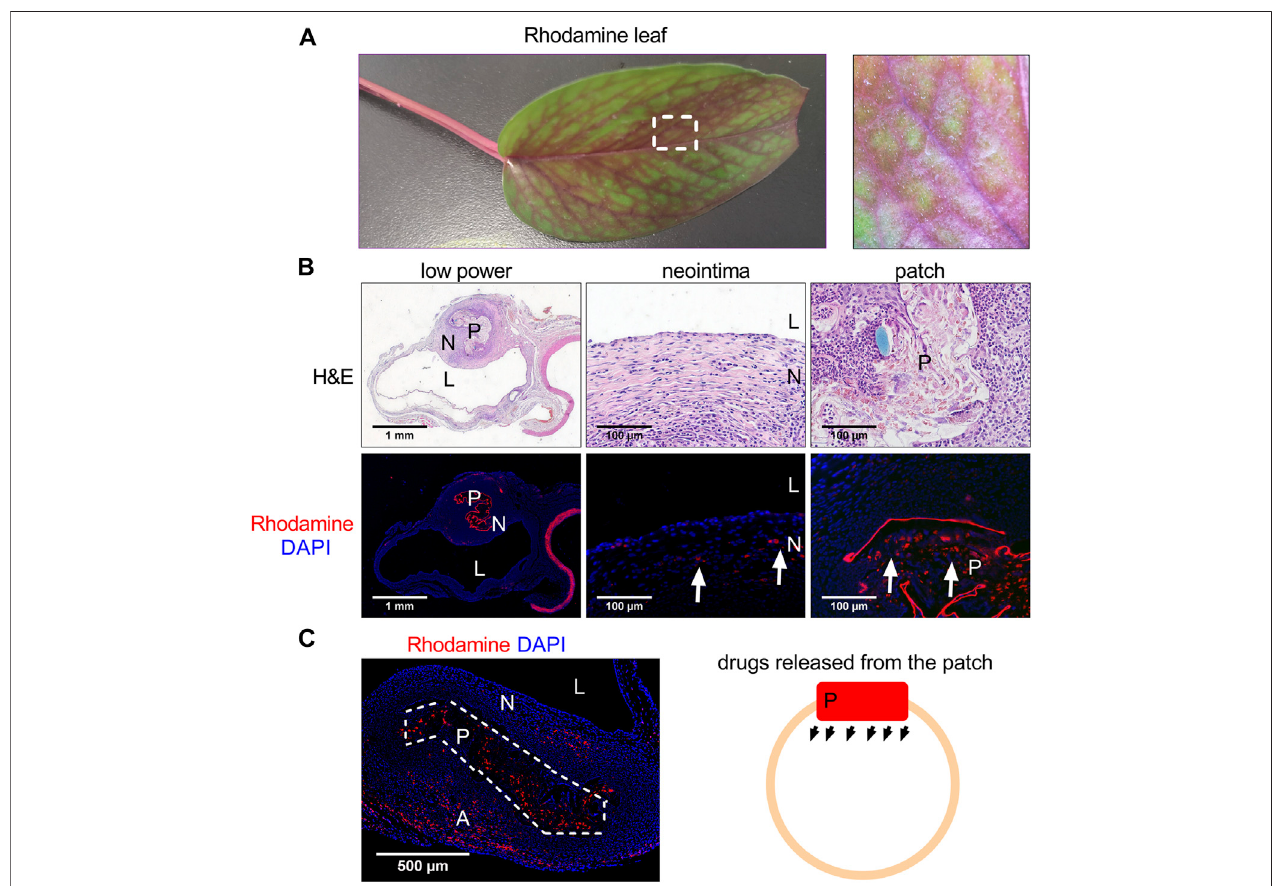
FIGURE2| Photographsshowingtheplantleafafterabsorption ofrhodaminewater. (A) Photographshowingtheplantleafafterabsorptionofrhodaminewaterat day 2. (B) Low and high-power photographs of hematoxylin and eosin (H&E) staining of the rhodamine plant leaf patch harvested at day 14, L, lumen; N, neointima; P, patch; scalebar,1 mm or 100 μ m; n (cid:2) 3. (C) Immuno fl uorescence photographs showingtherhodamineplant leafpatch harvested at day 14,L, lumen; N,neointima;P, patch; scale bar, 1 mm or 100 μ m; white arrow showing the rhodamine fl uorescence; n (cid:2) 3. (C) Immuno fl uorescence photograph and illustration photograph showing the rhodamine released from the patch, L, lumen; N, neointima; P, patch; A, adventitia; scale bar, 500 μ m; white dashed line area showing the patch; n (cid:2)